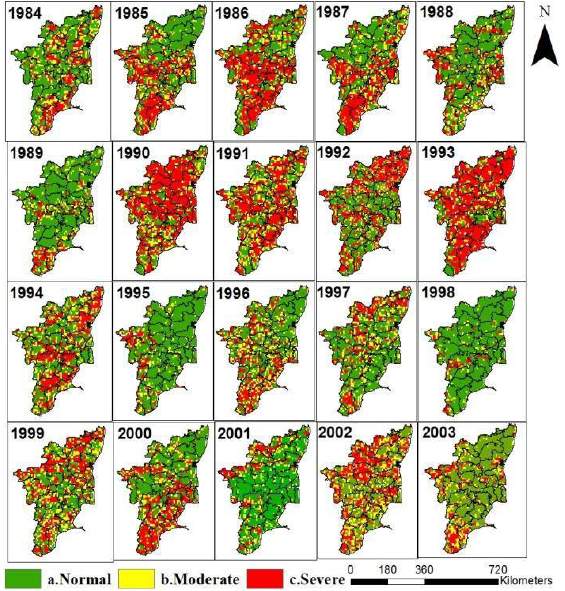
Figure 4 Drought intensity maps for 20 years during July 1st fortnight